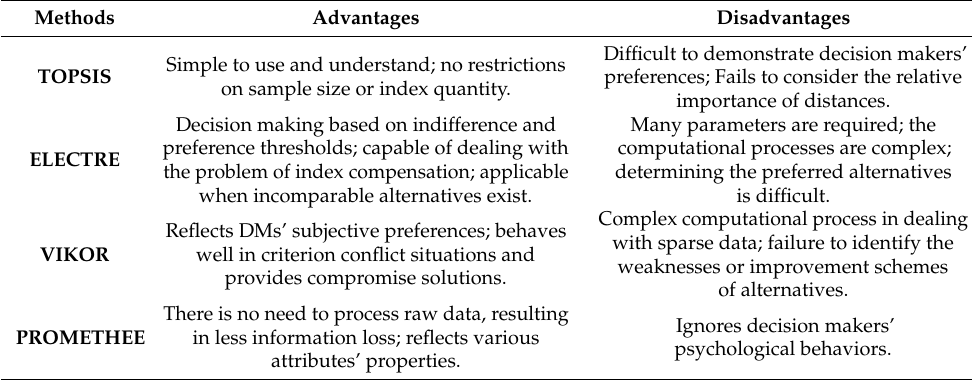
Table 5. Advantages and disadvantages of MCDM methods.